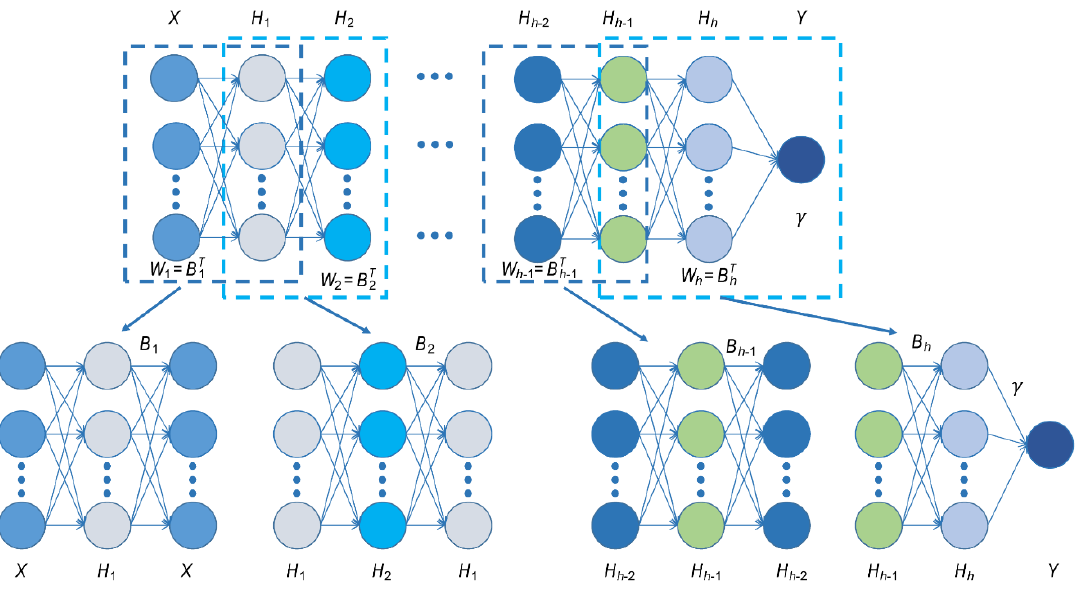
Figure 5. Semi-supervised hierarchical extreme learning machine structure [103]. Hierarchical extreme learning machine (HELM) is a multi-layer feedforward neural network composed of a multi-layer extreme learning machine-autoencoder (ELM-AE). During the training process, ELM-AE can achieve the lossless reconstruction of auxiliary variables. Therefore, the combined feature information of auxiliary variables can be extracted to a certain extent when the number of neurons in the hidden layer of ELM-AE is less than the number of neurons in the input layer [104]. The reconstruction loss function of ELM-AE is expressed as: